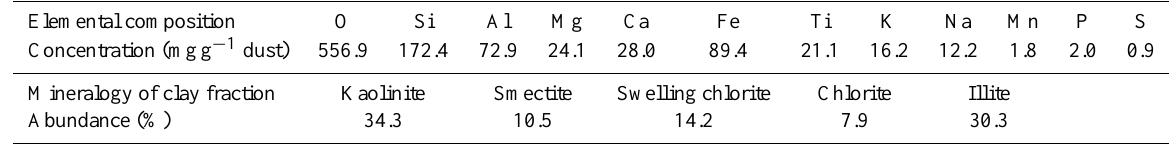
Table 1. Composition and mineralogy of SDCV adapted from Hanisch and Crowley (2003) and Coude-Gaussen et al. (1994), respectively. Elemental composition O Si Al Mg Ca Fe Ti K Na Mn P S Concentration (mgg − 1 dust) 556.9 Mineralogy of clay fraction